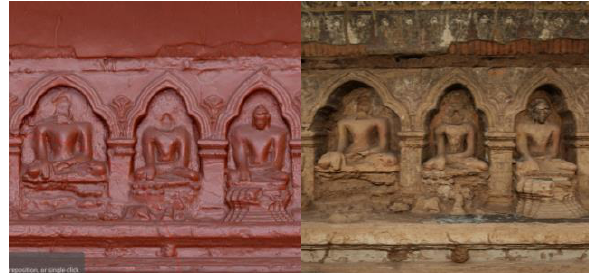
Figure 5. Low-poly compared with the final